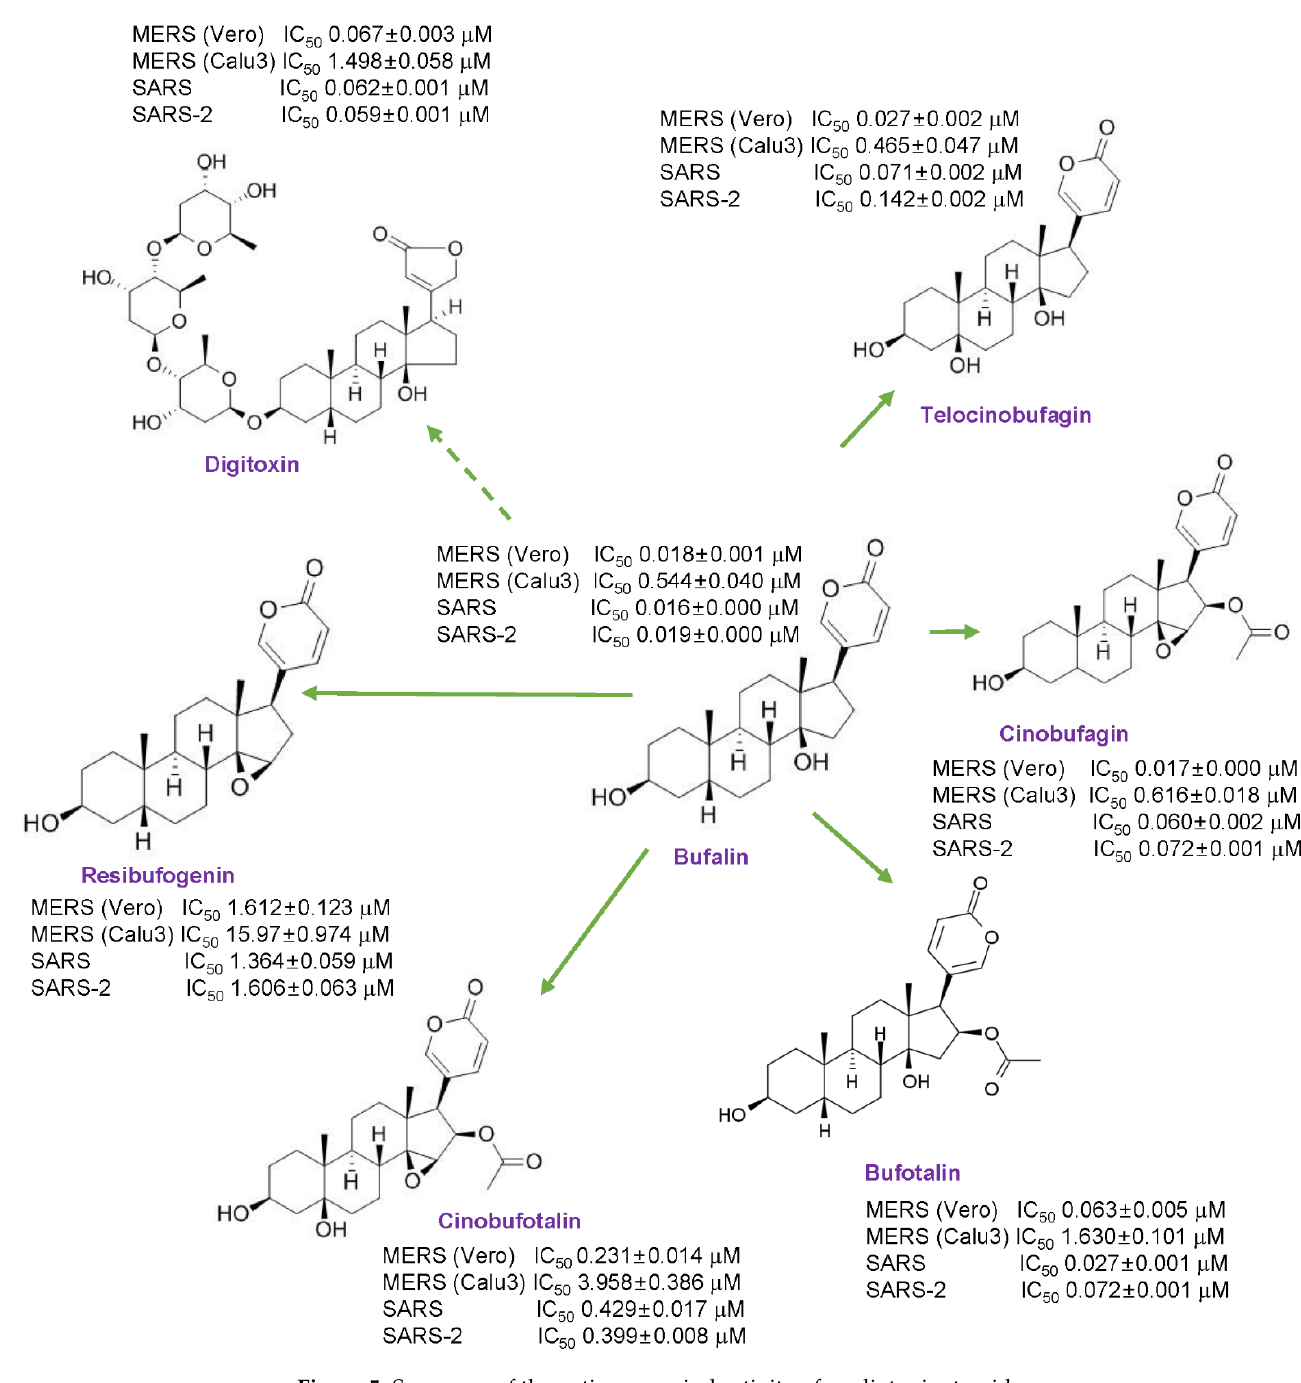
Figure 5. Summary of the anti-coronaviral activity of cardiotonic steroids. When the DEGs in Calu3 cells treated with the most potent anti-coronaviral com- pounds, cinobufagin, telocinobufagin, or bufalin, were investigated using QuantSeq 3′ mRNA-seq analysis, similar gene expression patterns were induced by cinobufagin, telocinobufagin or bufalin treatment during MERS-CoV infection. MERS-CoV infection upregulated cell death-related genes and immune- and inflammatory-related genes. However, this upregulated gene expression was reversed by these compounds. Data also suggested that the levels of C/D-class small nucleolar RNAs (SNORDs) and H/ACA small nucleolar RNAs (SNORAs) were regulated by MERS-CoV infection, and these were re- versed by these compound treatments. Small nucleolar RNAs (snoRNAs) are noncoding